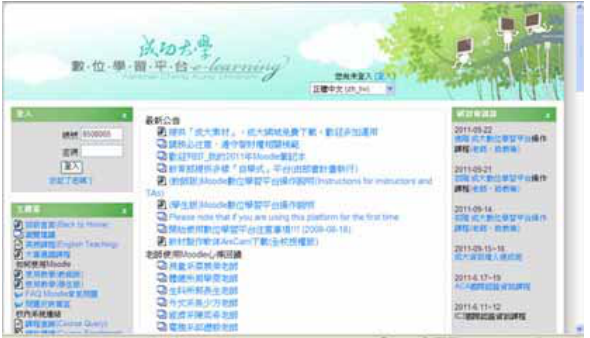
Figure 4. Homepage of the NCKU E-learning Moodle system (website: